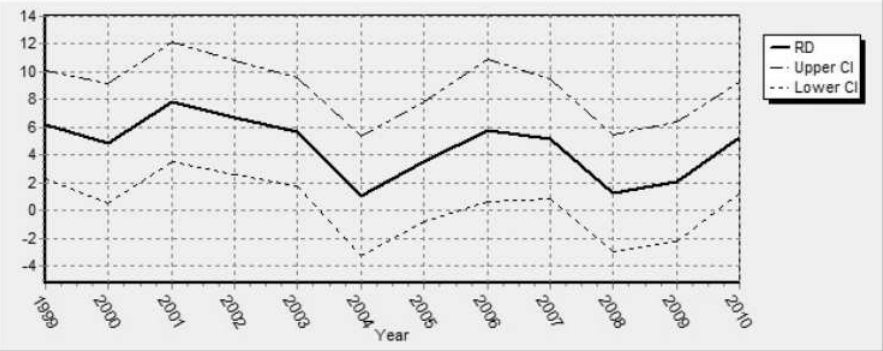
Figure 2. Trends of rate difference of age-standardised incidence rates among women in Świętokrzyskie, years